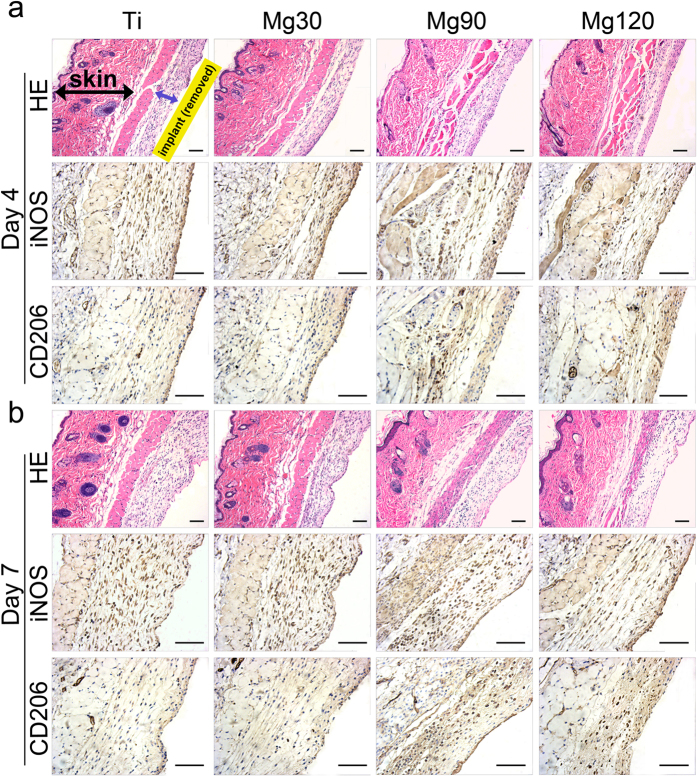
Haematoxylin-eosin (HE) and immunohistochemistry (iNOS and CD206) analysis of tissues adjacent to the indwelling samples at day 4 (a) and day 7 (b). Blue arrows: fibrous layer. Yellow rectangle: indicate the location of implants. Scale bar: 50 μm.